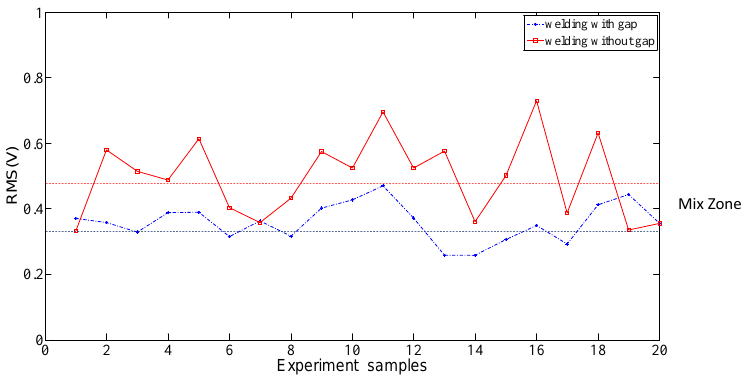
Figure 7. Root-mean-square (RMS) values of full-length sound signals for 20 samples with normal joint strength, and 20 samples with low joint strength.